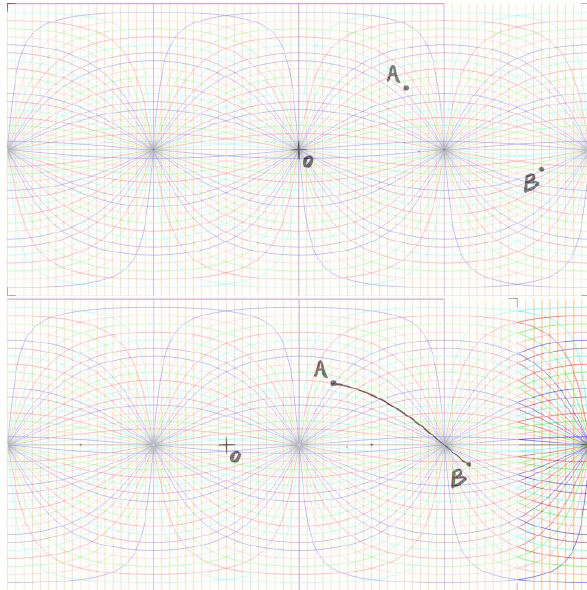
Figure 11 | Top: Two arbitrary points A and B, not in the same horizontal or vertical. Bottom: Horizontal translation of the drafting paper over the grid finds the single great circle that connects A and B – in this case at a 45º shift. This is the value of 𝜆 𝑀 , read directly from the new position of mark 𝑂 . It is much easier to spot the curve when using a grid that is very fine but separates adjacent lines by color, for easy identification when crossing the equator. An adequate grid is available at the author’s web site.